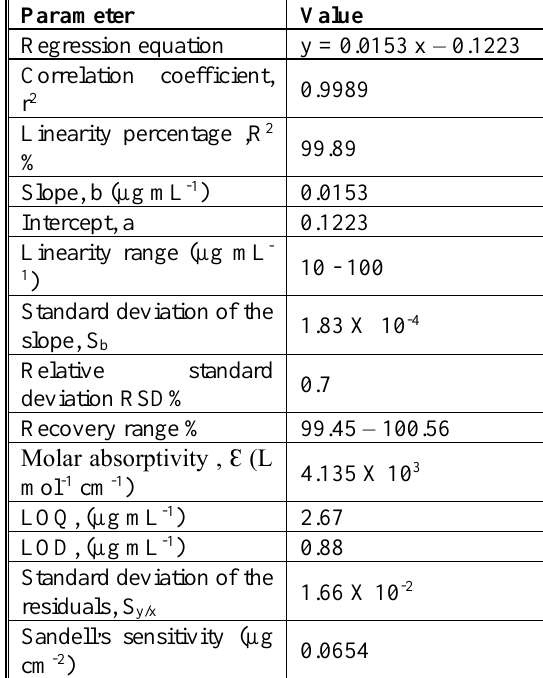
Table 2. Analytical values of the techniques